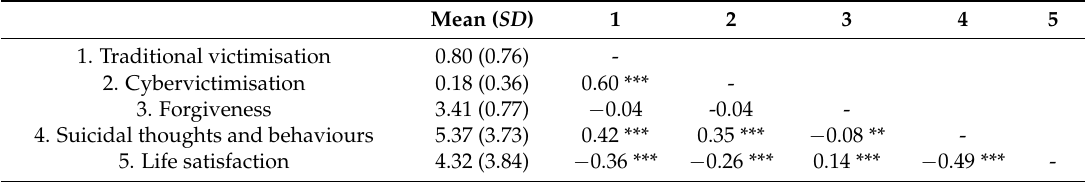
Table 1. Means, SD s and intercorrelations among